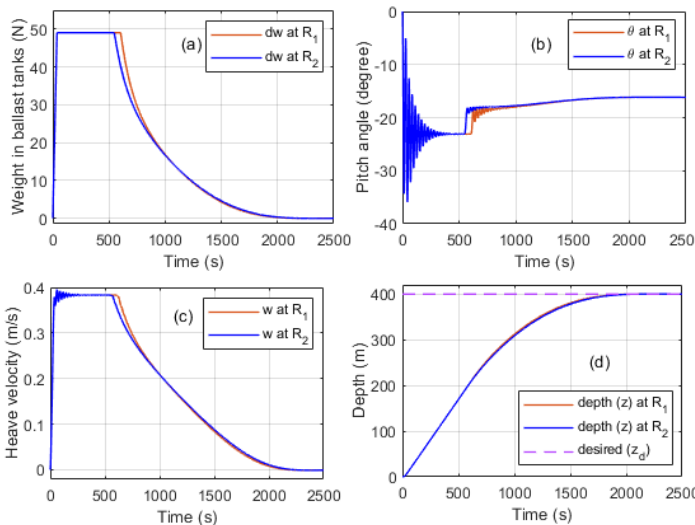
Figure 15. ( a ) Variation of the weight vs. time in ballast tanks, ( b ) pitch angle with time, ( c ) sinking (heave) velocity with time and ( d ) depth with time in closed loop for two different state weighing matrices.